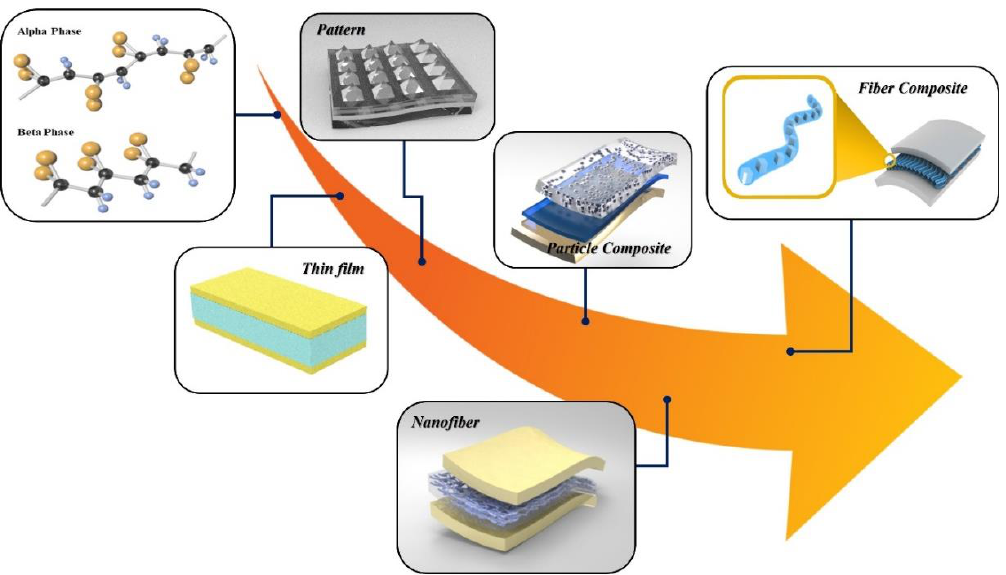
Figure 1. A schematic illustration of the various structured polyvinylidene fluoride (PVDF)-based piezoelectric nanogenerators.